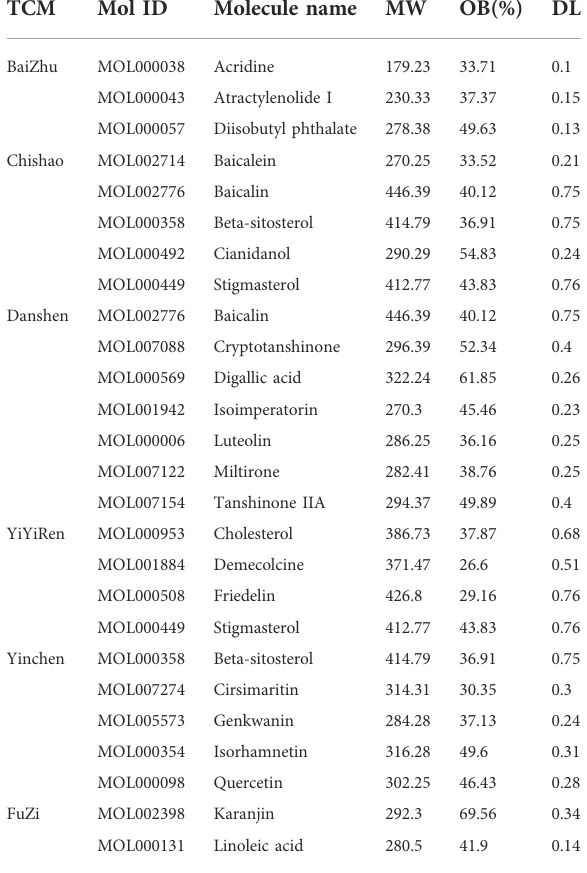
TABLE 1 Main active ingredients with targeted genes in herbs of the WenyangJiedu Huayu formula, according to theTCMSPdatabase and PubChem